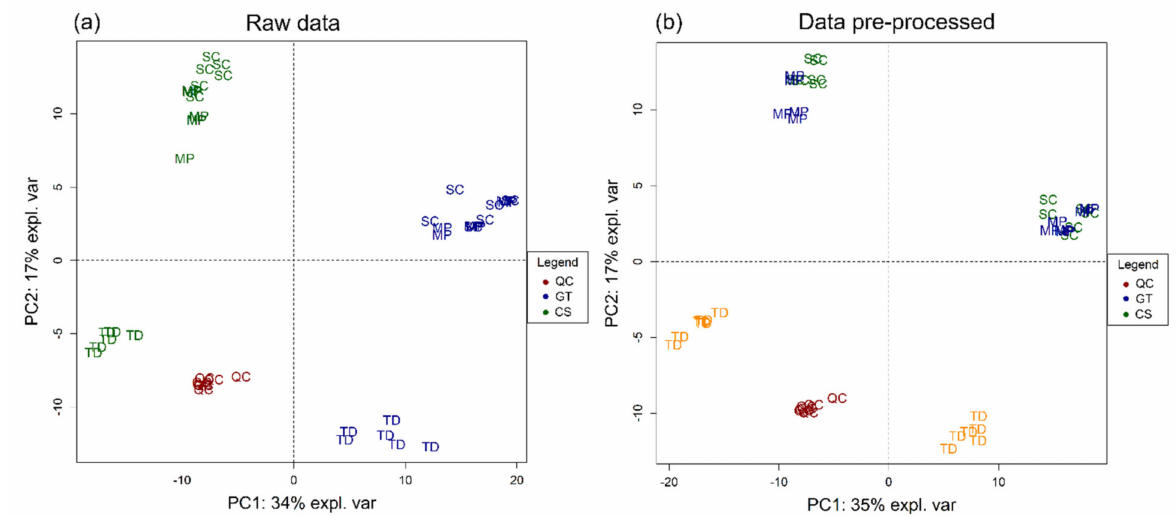
Figure 2. Principal component analysis (PCA) performed for the gas chromatography (GC) data during pre-treatment. ( a ) Raw data and ( b ) pre-treated data. Quality control samples (QCs) are included to verify the quality of the data. TD : wines fermented with sequential inoculation of Torulaspora delbrueckii and Saccharomyces cerevisiae . MP : wines fermented with sequential inoculation of Metchnikovia pulcherrima and Saccharomyces cerevisiae . SC : wines fermented with monoculture of Saccharomyces cerevisiae